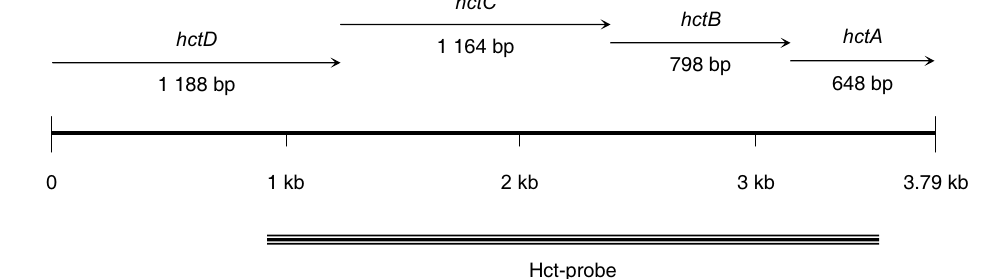
FIG. 3 Amplification of the regions up- and downstream from the Hct-probe sequence within the ~6.15 kb clone. A ~1.5 kb fragment was amplified when oligonucleotide HctD-1R was used in combination with T7 (lane 1). A ~2.1 kb fragment was amplified by oligonucleotides HctA-1F and SP6 (lane 2)